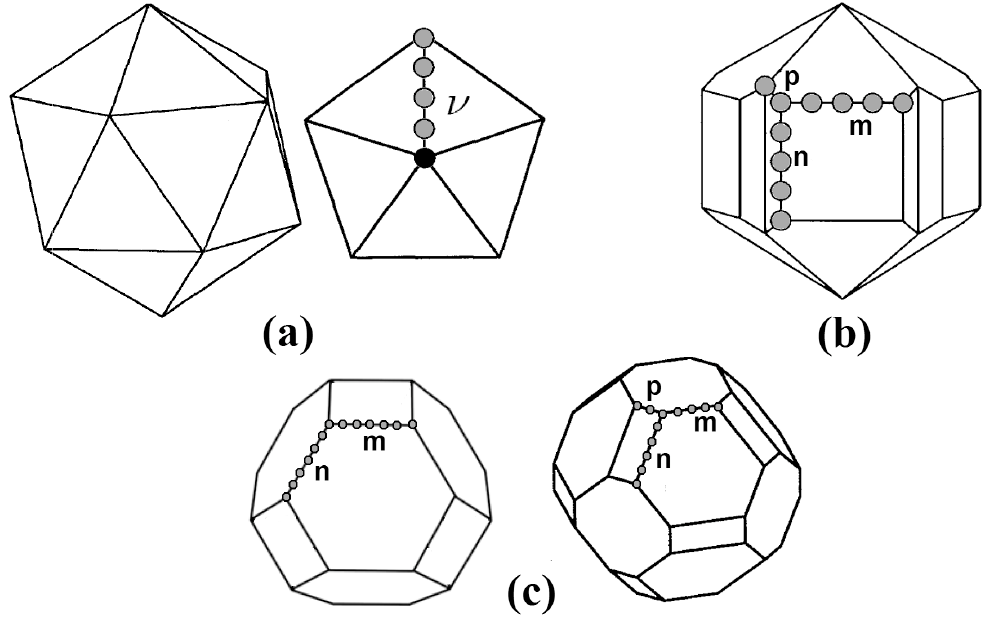
Figure 5. ( a ) ideal I geometry. The atoms shared between two triangular facets define h the order ν of the icosahedron; ( b ) n × m × p Marks decahedron, characterized by the v-shaped cuts of depth p into the edges of the n × m facets; ( c ) Two kinds of n × m × p truncated